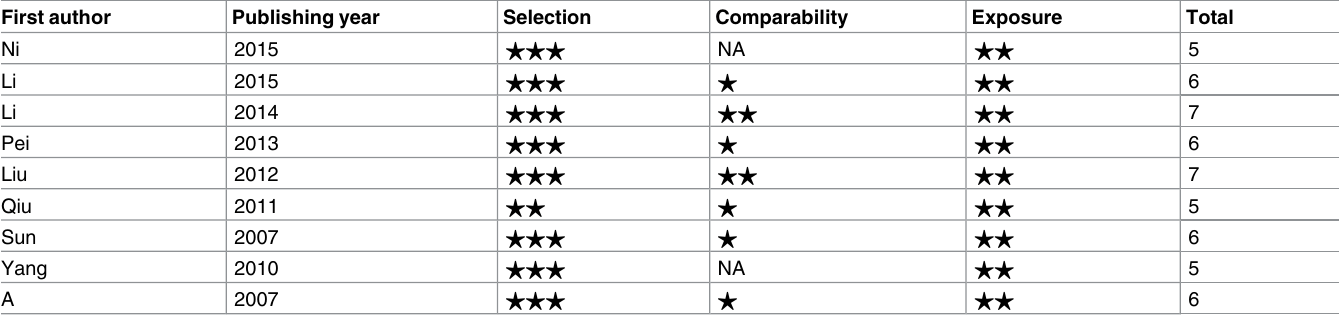
Table 2. Quality assessment for all of the included